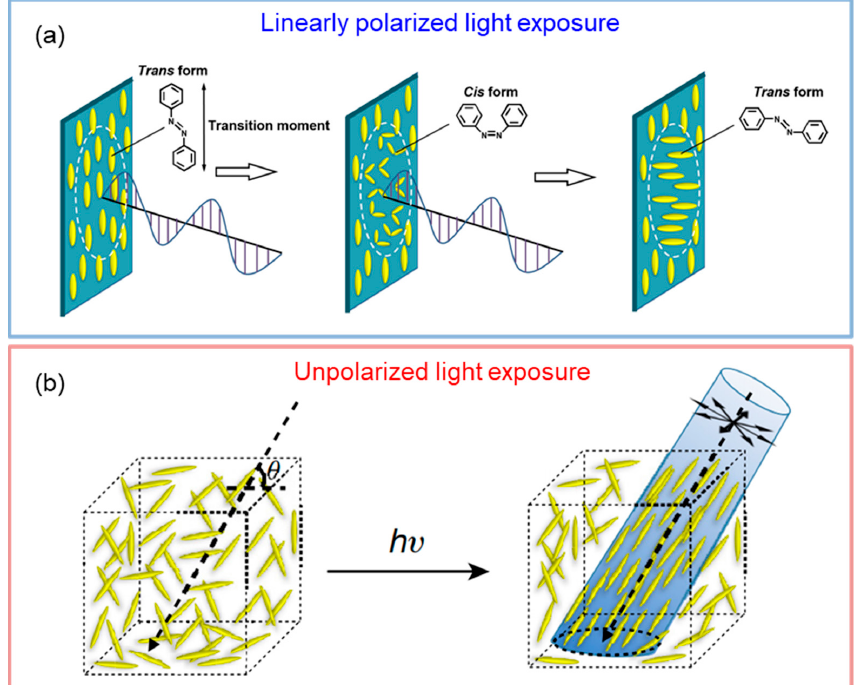
Figure 8. Schematic illustrations of the photoaligning process of the azobenzene molecules. ( a ) When azobenzene molecules are exposed to linearly polarized UV light, molecules are reoriented orthogonally to the applied linear polarization. ( b ) However, if azobenzene molecules are shined on with unpolarized UV light, the molecules change their orientation to the UV-shining direction. Reprinted with permission from [75], Copyright 2016, Springer Nature.